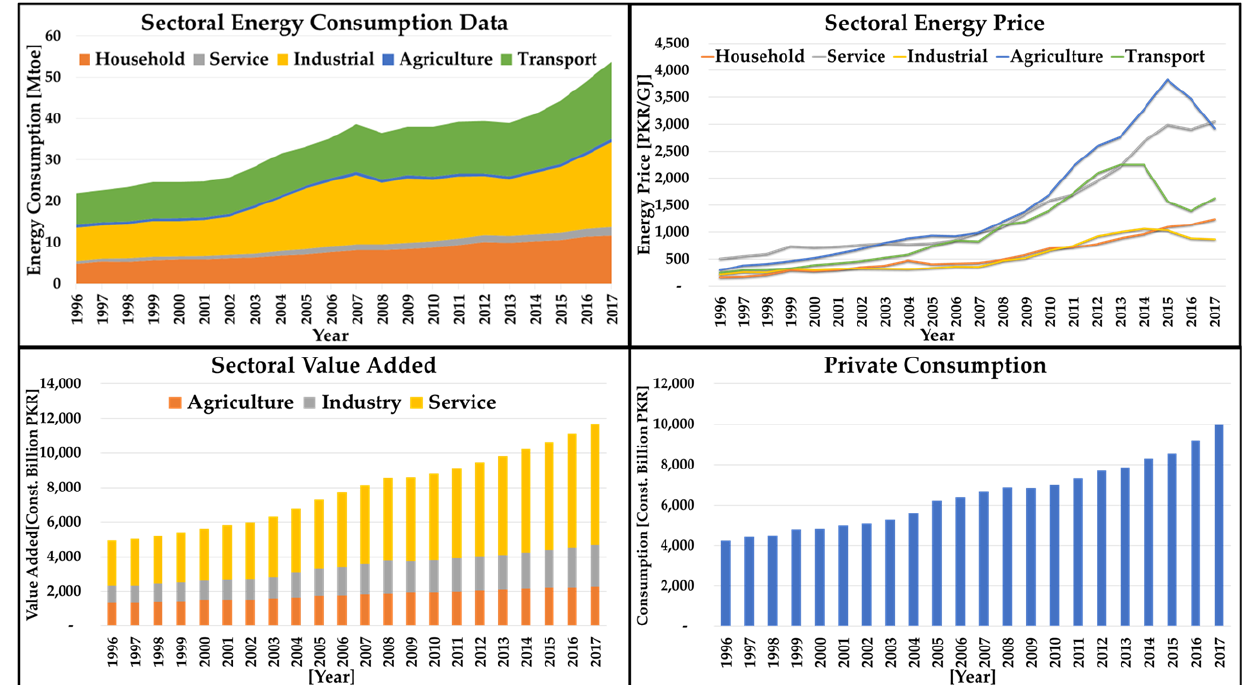
Figure 8. Timeseries data of parameters used in top-down energy demand model. Car ownership (number of cars per 1000 persons) is computed using population and on-road cars [33,37]. The rest of the parameters in Table 9 are calculated for the given demand of energy consumption in the transport sector